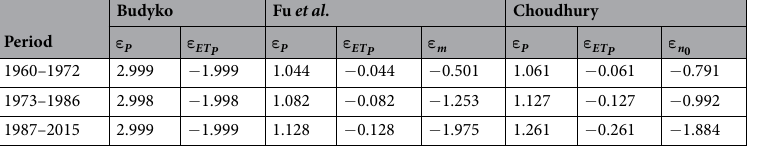
, the blue dots represent P